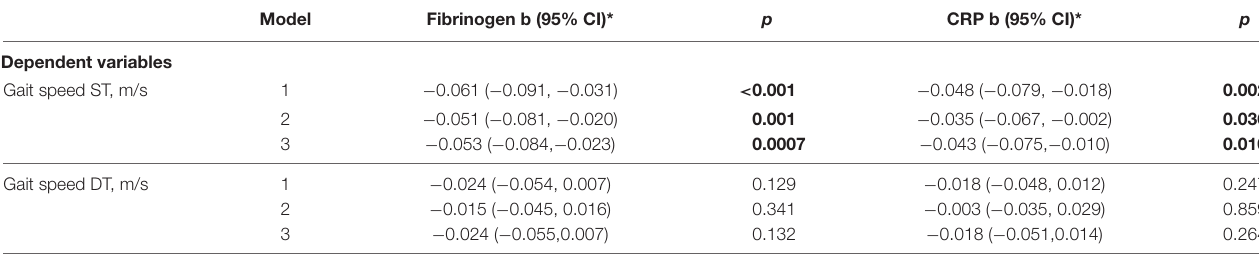
TABLE 2 | Associations between inflammation markers and gait speed under ST and DT conditions 20 years later.